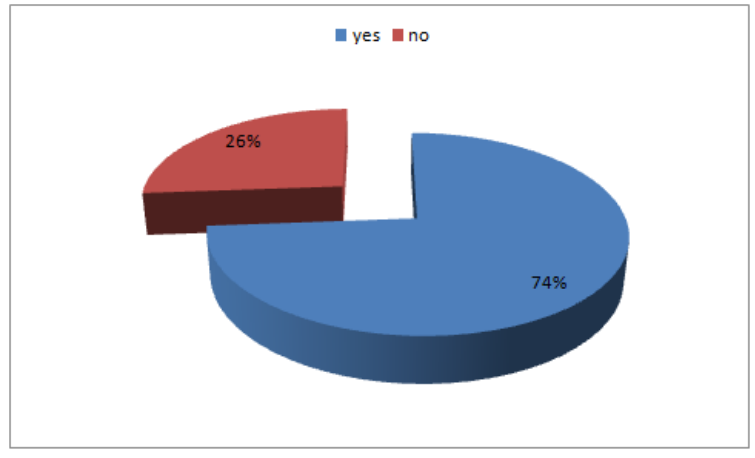
Figure 7: The E-Banking and Competitiveness